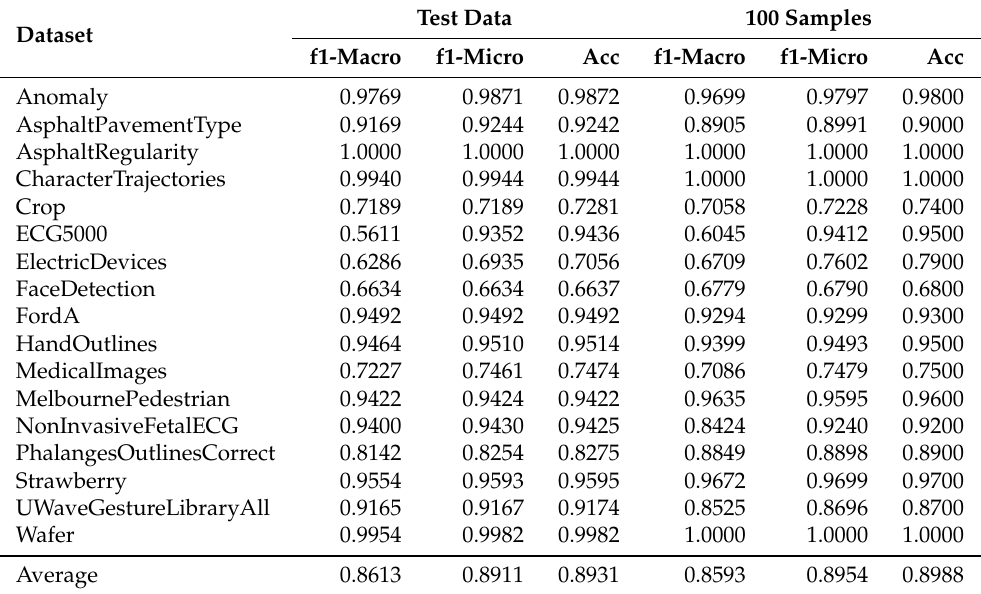
Figure 2. InceptionTime. Shows the general architecture of InceptionTime proposed by Fawaz et al. [24]. The architecture shows that there are several inceptionblocks consisting of con- voluition layers. Furthermore, the network has residual connections to skip some inceptionblocks. After the last inceptionblock there is a global average pooling followed by a fully connected layer to produce the output classification. Figure taken from [24]. Table 2. Performance of IncpetionTime. Concerning the accuracy, and f1 scores the subsampled dataset achieves similar performance and can be used as a set of representative samples for further experiments. The results show that the subset accuracy is equal to the complete test set